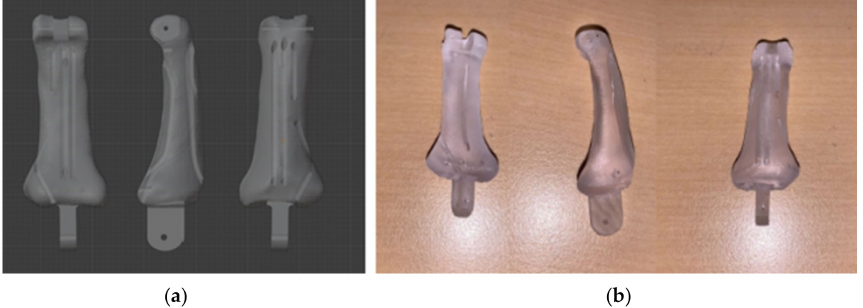
Figure 4. Design of tendons and tunneled tube in bone: ( a ) 3D model; ( b ) 3D printed